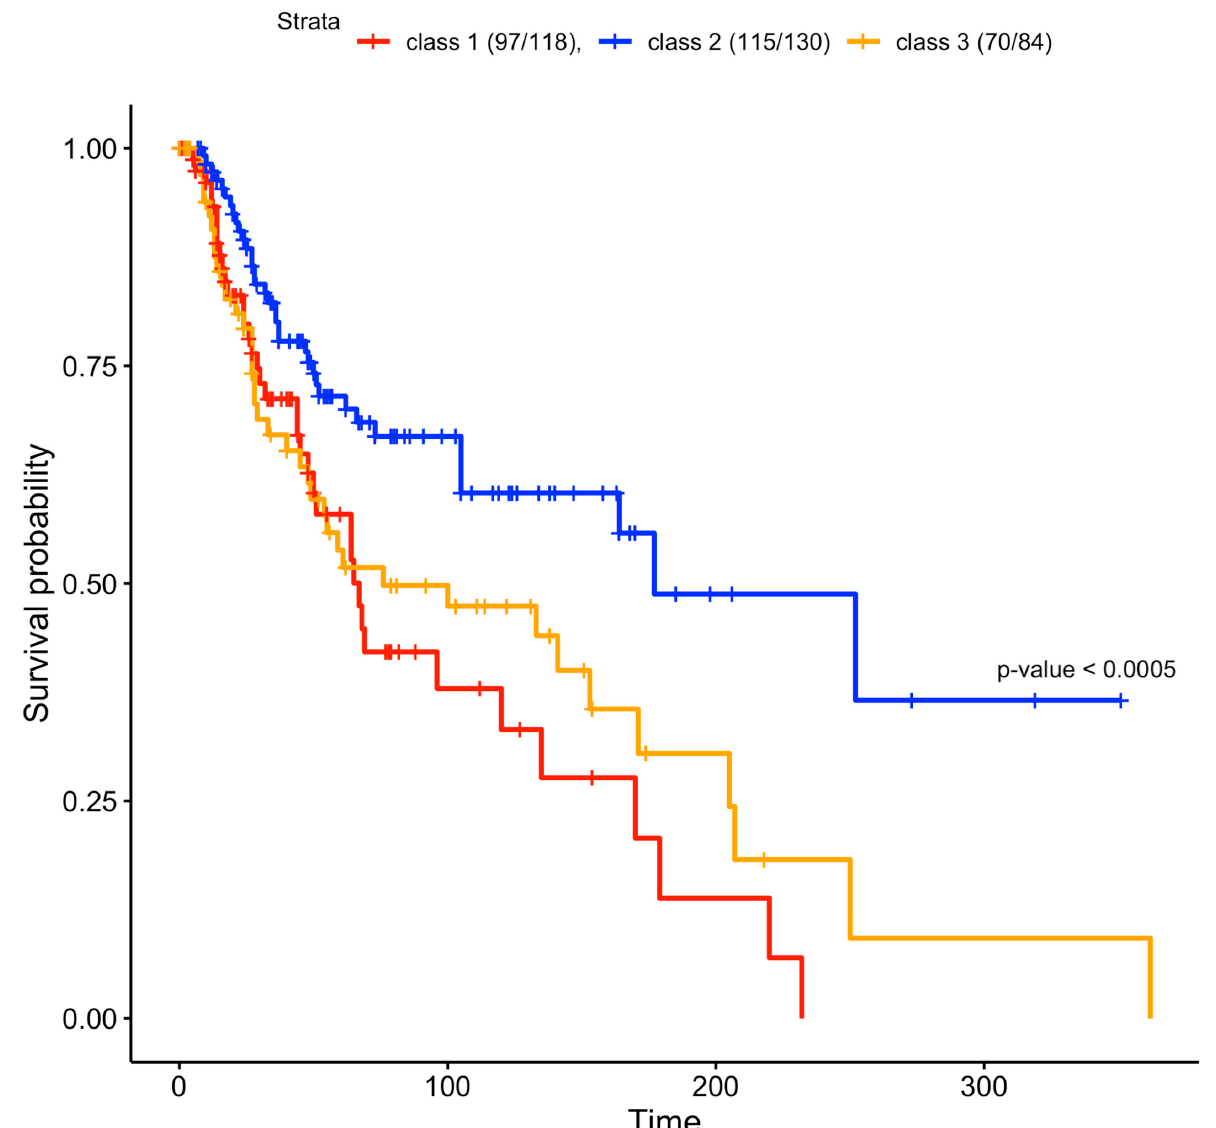
Figure 4. Survival curves of the three clusters found in the jSVD data fusion. Clusters 1 and 3